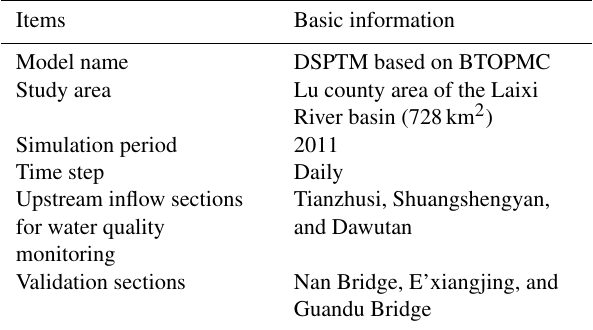
Table 5. Basic information for DSPTM